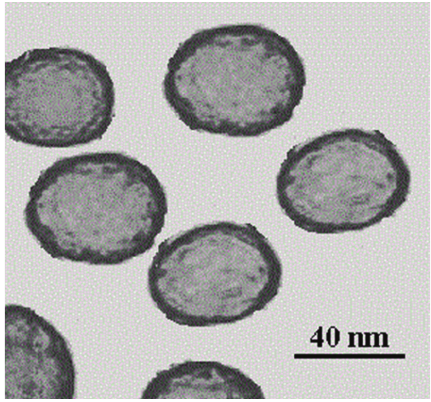
Figure 6: TEM image of hollow silica nanostructures.